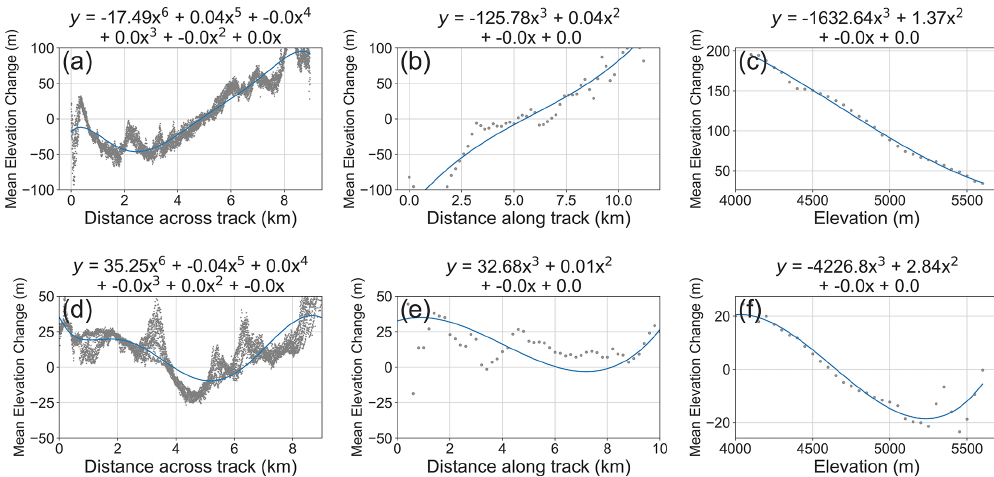
Figure 2. Non-linear biases for the 1956 (a–c) and 1978 (d–f) DEMs when elevations are compared against the 2020 DEM over the stable (non-glacial, non-fluvial)